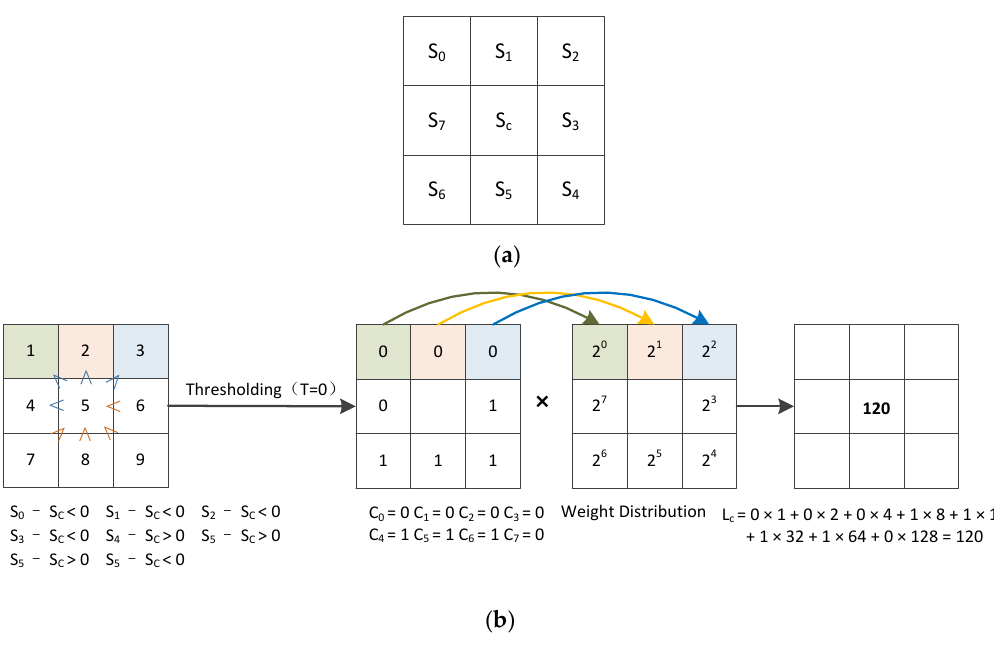
Figure 4. The value of the local binary pattern (LBP) is 8 + 16 + 32 + 64 = 120. ( a ) The 3 × 3 region; ( b ) the calculation of the LBP.